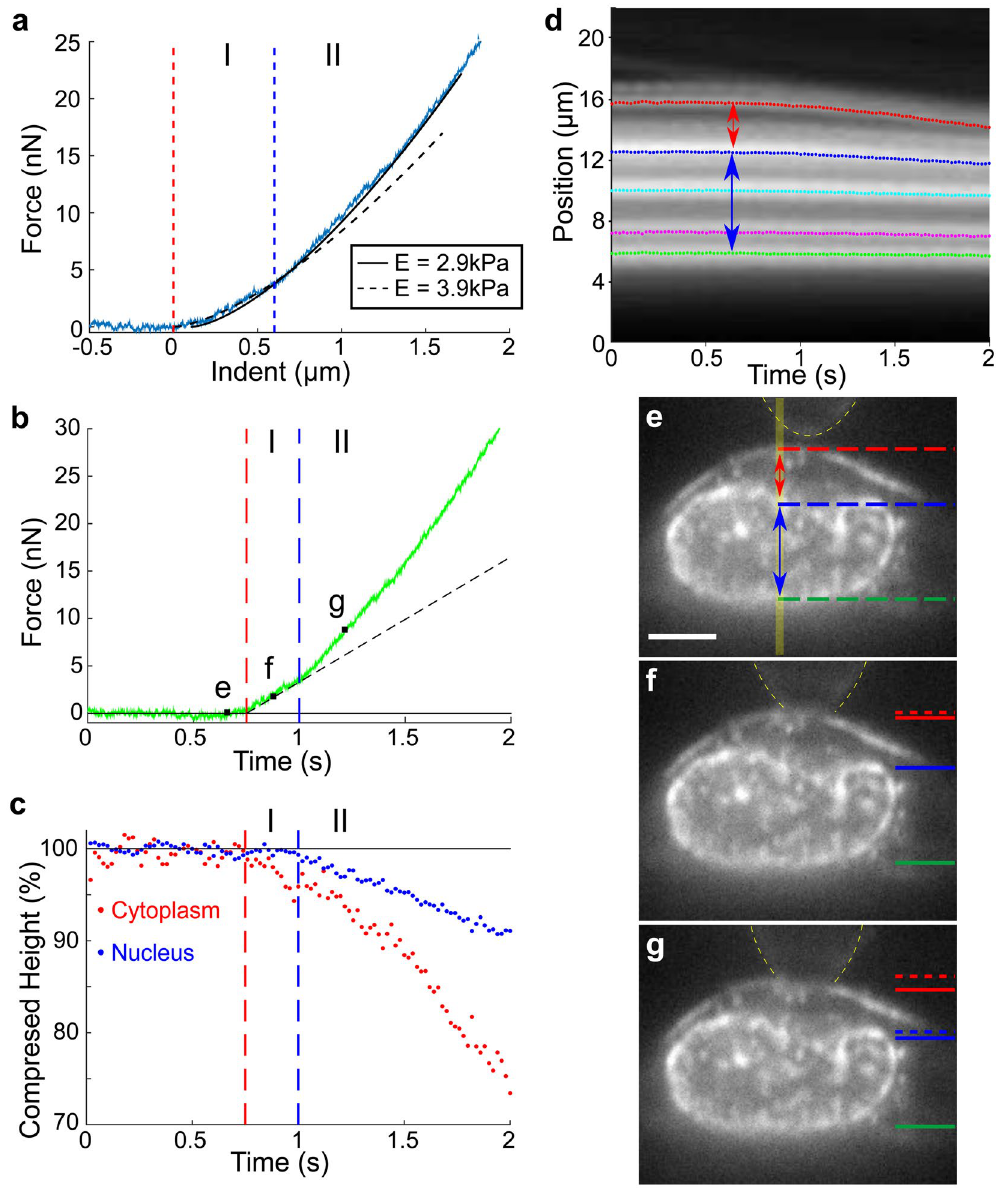
Figure 3. Stiffening of SKOV3 cell corresponds to onset of nuclear deformation. ( a ) AFM force vs. indentation data on SKOV3 cell fit to a two regime Hertz model, with the transition point (indicated by blue dashed line) determined through least squares fitting. ( b ) Force vs. time plot of same data as ( a ). Transition point from regime I to regime II as determined in ( a ) shows an abrupt change in slope. ( c ) Normalized compressed height vs. time of the cytoplasm region above the nucleus and the nucleus during indentation, as determined using kymograph data ( d ). The cytoplasm is defined as the region between the cell membrane (red) and the top of the nucleus (blue) indicated by red arrow in ( d ), and the nuclear region, indicated by blue arrow, is defined by the kymograph traces at the top (blue) and bottom (green) of the nucleus in ( d ). ( d ) Kymograph of the yellow region under AFM tip (indicated by vertical yellow bar in ( e )) over the course of indentation with Gaussian tracked intensity peaks. The dotted curves correspond to the cell membrane (red), top of the nuclear region (blue), punctate labeled structures within nucleus (cyan and magenta) and the bottom of the nuclear region (green). ( e – g ) Sample images from a time sequence acquired simultaneously with force data, as identified on the force vs. time trace ( b ). Dashed lines on the left of the images indicate the initial position of the traced cytoplasm (red) and nucleus (blue) regions and solid lines indicate the current positions. Yellow dashed lines indicate outline of AFM mounted bead. Scale bar in (e) = 5